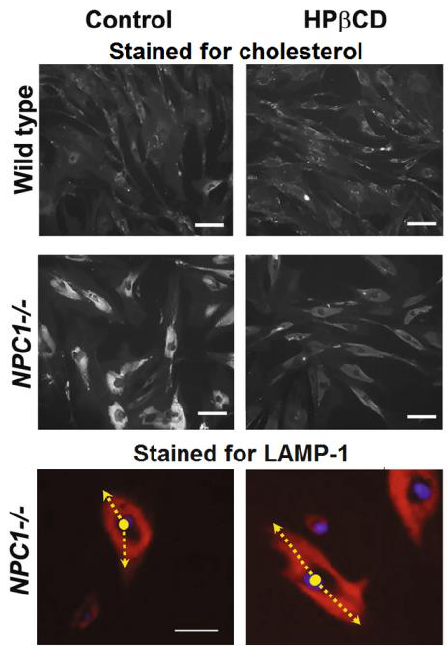
Figure 2. Immunostaining micrographs of healthy fibroblasts (wild type) and fibroblasts from a Niemann – Pick patient ( NPC1 −/− ); scale bar = 50 μm . Top and middle rows show the distribution of cholesterol (in white, stained with filipin). Bottom row shows LAMP-1 distribution (in red, a lysosome marker) along with the cell nuclei (in blue). The arrow represents the distribution of LAMP-1 from the centre of the nuclei, depicting that the LAMP-1 protein is mostly confined to the area near the nuclear envelope in control NPC1 − / − cells and distributed more widely throughout the cytoplasm when cells were treated with HP β CD. Cells were incubated with 1 mm HP β CD for 72 h prior to image collection. Images are a representative of at least three random fields of three experimental replicates. Adapted from Singhal et al. [45] under a Creative Commons licence (CC BY